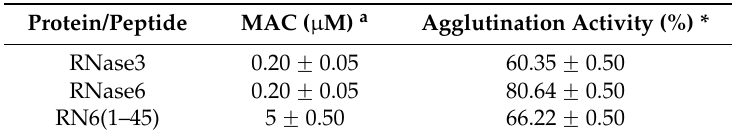
Table 7. MAC and bacterial agglutination percentage of RNase3, RNase6 and RN6(1–45) for E. coli cell cultures.